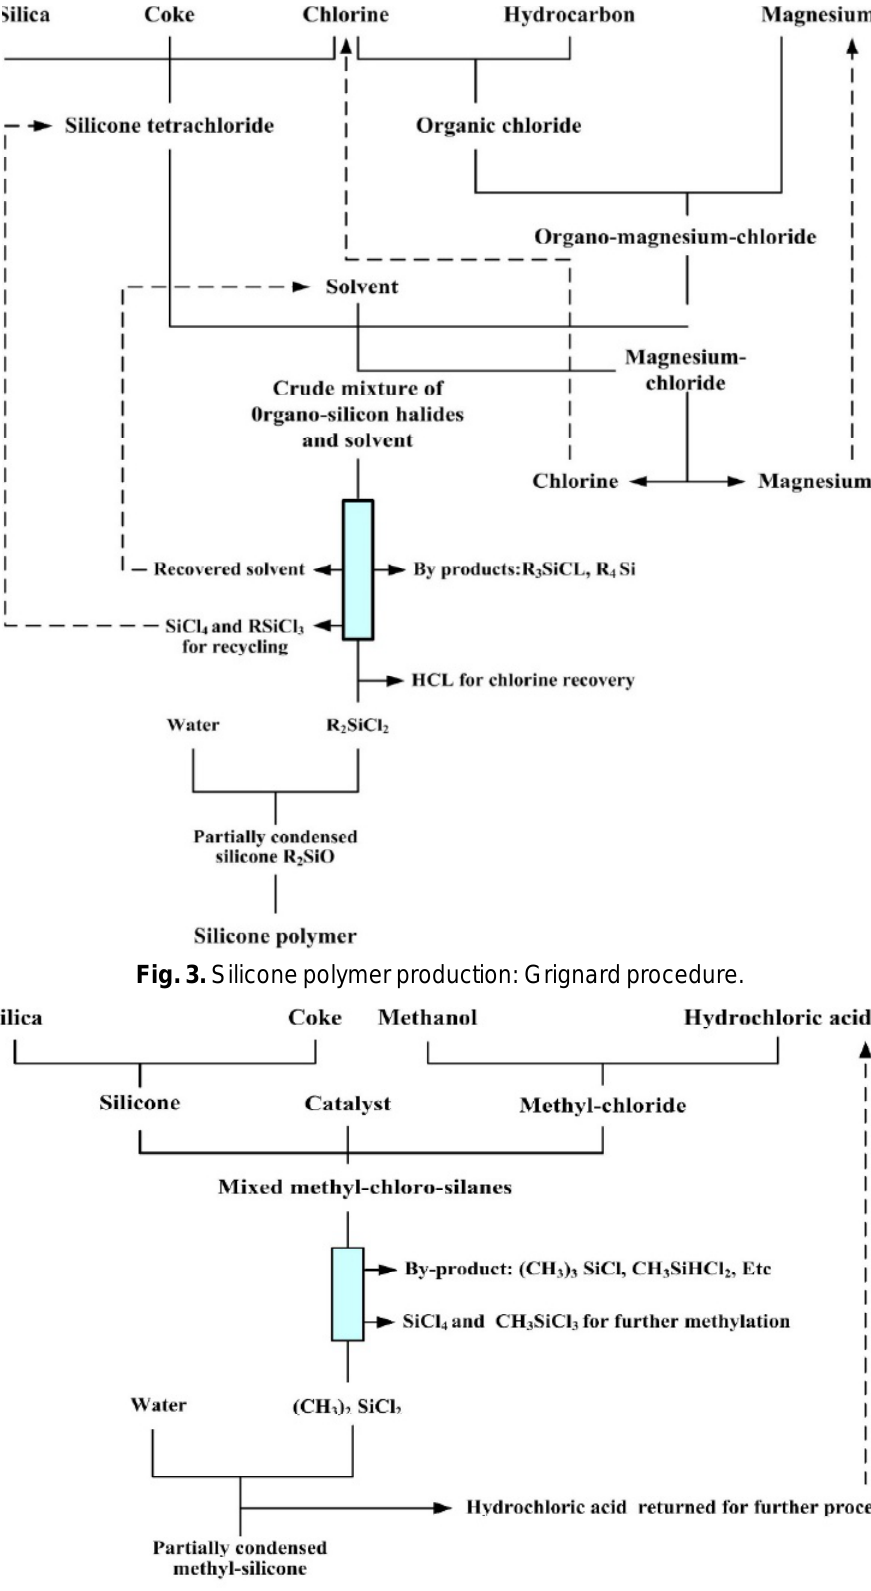
Fig. 4. Direct method: Methyl-silicone polymer